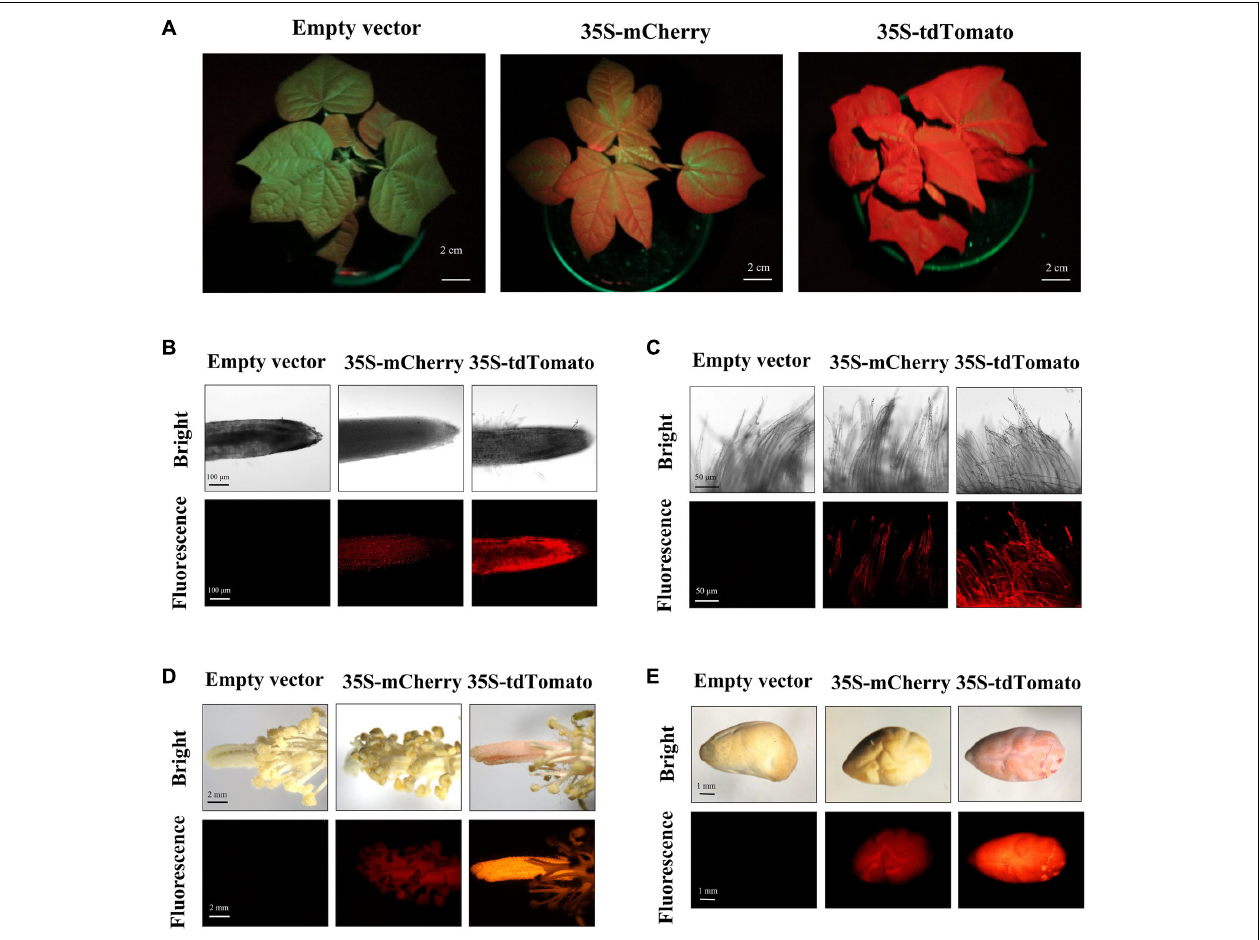
FIGURE 2 | Red fluorescent protein (RFP) fluorescence in different tissues/organs of transgenic regenerated T 0 plants. (A) Transgenic cotton plants expressing RFP during vegetative growth showed red fluorescence in their whole aerial portions under excitation spectra; scale bar, 2 cm. (B–E) The root (scale bar, 100 µ m), fiber (scale bar, 50 µ m), stamen/pistil (scale bar, 2 mm), and seed (scale bar, 1 mm) of transgenic regenerated cotton plants expressing empty vector and RFP under white light (bright) and excitation light